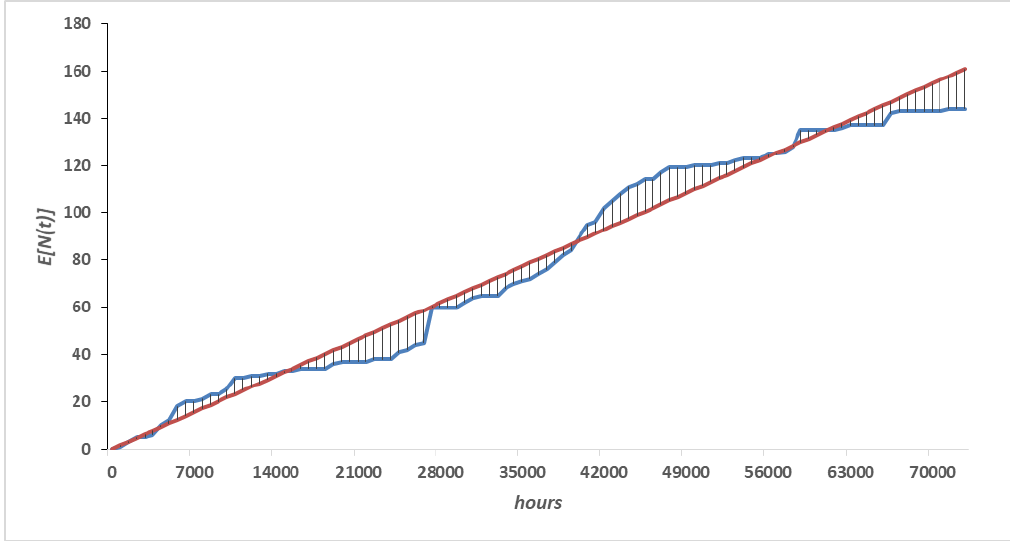
Figure 2. Linear simple regression model of the escalator number 6.